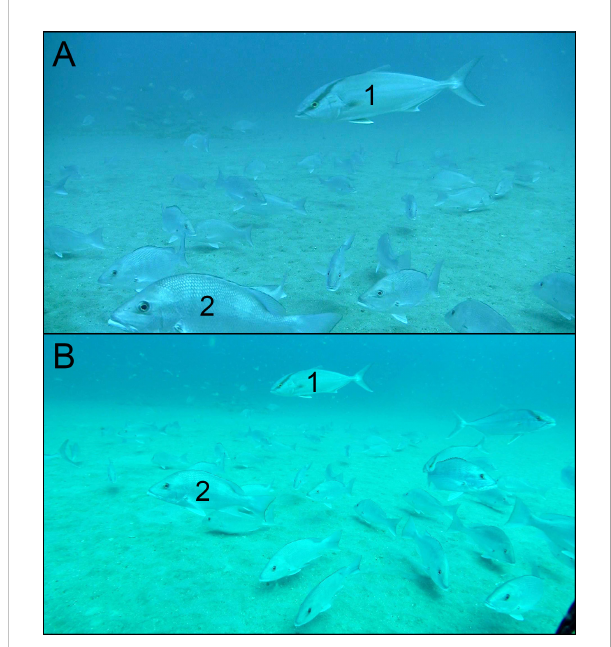
FIGURE 2 Differences in fi eld of view between two underwater video cameras, paired in space and time, from a sample of the Southeast Reef Fish Survey off Jacksonville, Florida, taken in 2014. (A) Image from a Canon ® Vixia HF-S200 video camera in Gates underwater housing. (B) Image from GoPro Hero 3+ camera in stock underwater housing. Numbers are shown so readers can identify and compare the same individual fi sh in each image: (1) almaco jack Seriola rivoliana ; (2) red snapper Lutjanus campechanus